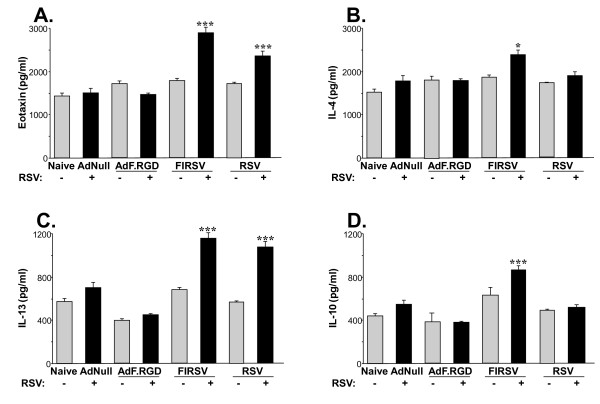
Absence of RSV-induced inflammatory responses in lung and BAL following immunization with AdF.RGD. BALB/c mice were immunized subcutaneously with AdNull, AdF.RGD (both at 1010 pu), formalin-inactivated RSV (FIRSV, 105 pfu) or intranasally with RSV (106 pfu). Five wk later the mice were challenged intranasally with RSV (106 pfu) and lungs were harvested after 6 days. A-D. Cytokine levels in homogenates: A. Eotaxine levels in lung homogenate. B. IL-4 levels in lung homogenate. C. IL-13 levels in lung homogenate. D. IL-10 levels in lung homogenate Data are shown as mean ± SEM of duplicate measurements of n = 4 mice/group and represent one of two independent experiments.*** and * denote significance of p < 0.001 and p < 0.05, respectively.